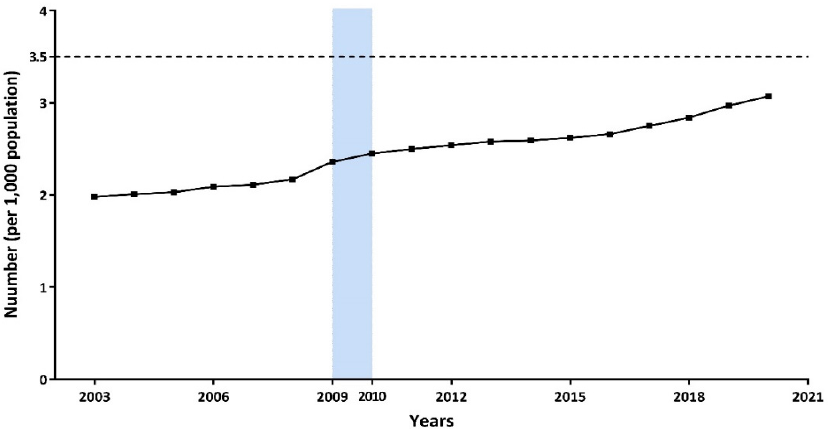
Figure 1. Number of primary health workers per 1000 population from 2003 to 2020. Table 1. Changes in the number of staff in primary health ‐ care institutions in China a . Indicators